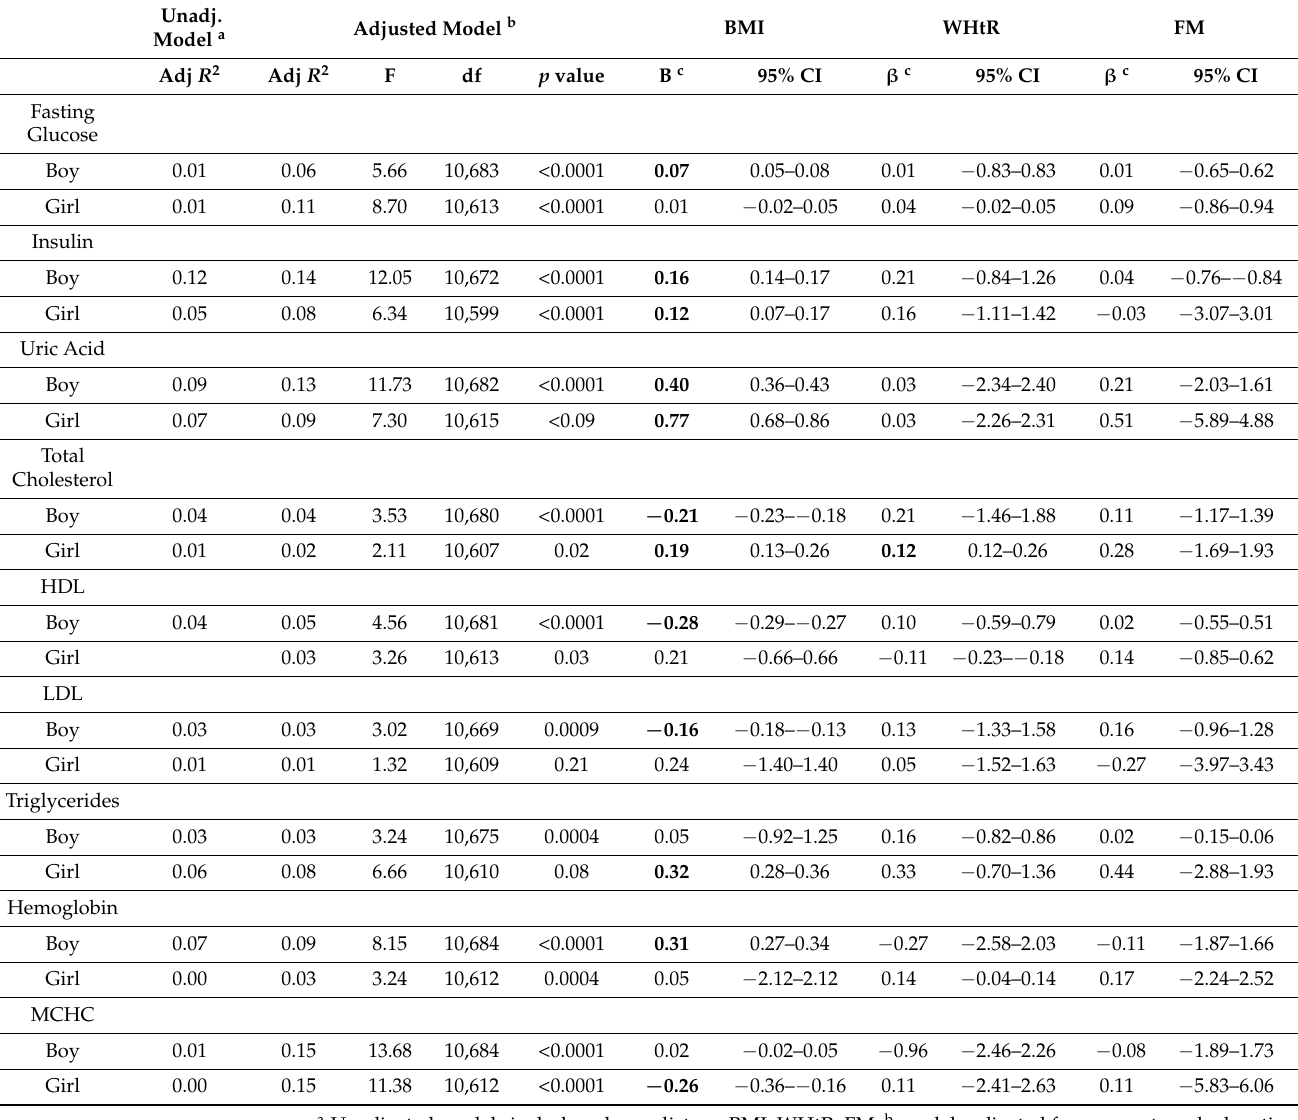
Table 4. Adiposity in relation to each cardiometabolic and iron